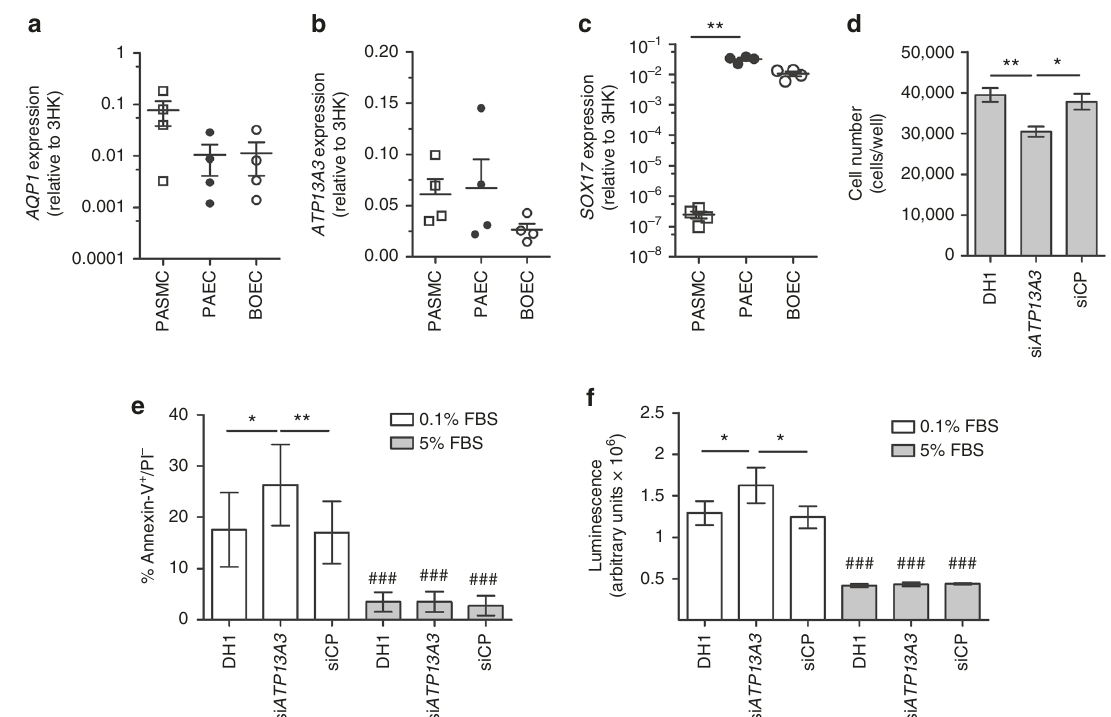
Fig. 10 Functional studies of novel genes. a – c Expression of a AQP1 , b ATP13A3 and c SOX17 mRNA in human pulmonary artery smooth muscle cells, pulmonary artery endothelial cells and blood outgrowth endothelial cells (BOECs) ( n = 4 biological replicates of each). Relative expression of each transcript was normalised to three reference genes, ACTB , B2M and HPRT . d Proliferation of BOECs in 5% FBS over 6 days. Cells were transfected with DharmaFECT1 alone (DH1), si ATP13A3 or non-targeting siRNA control (siCP) e , f Quanti fi cation of apoptosis in BOECs, de fi ned as Annexin V + /PI − cells, in BOECs transfected with si ATP13A3 or siCP in complex with DH1 followed by 24 h treatment with 0.1% FBS or 5% FBS ( n = 4 biological repeats). f Measurement of apoptosis via Caspase-Glo 3/7 activity measurements in BOECs transfected with si ATP13A3 or siCP in complex with DH1, followed by 16 h treatment in 0.1% FBS or 5% FBS. Data are from a single experiment ( n = 4 wells) representative of 3 biological repeats. Data were analysed using